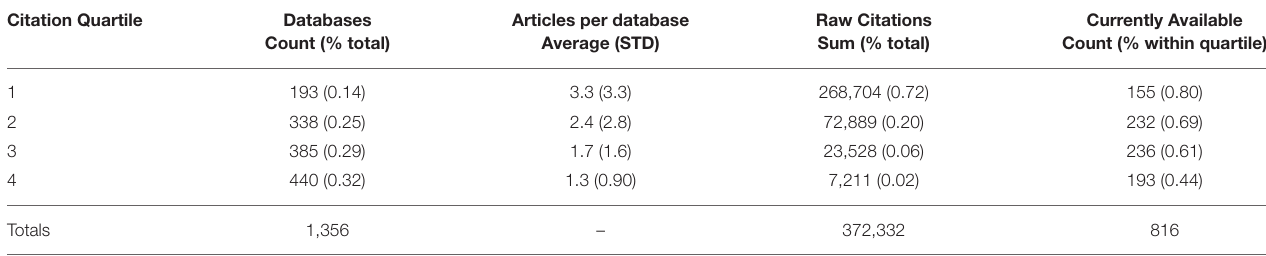
TABLE 1 | Citation analysis for databases with articles published 1991–2012. Citation